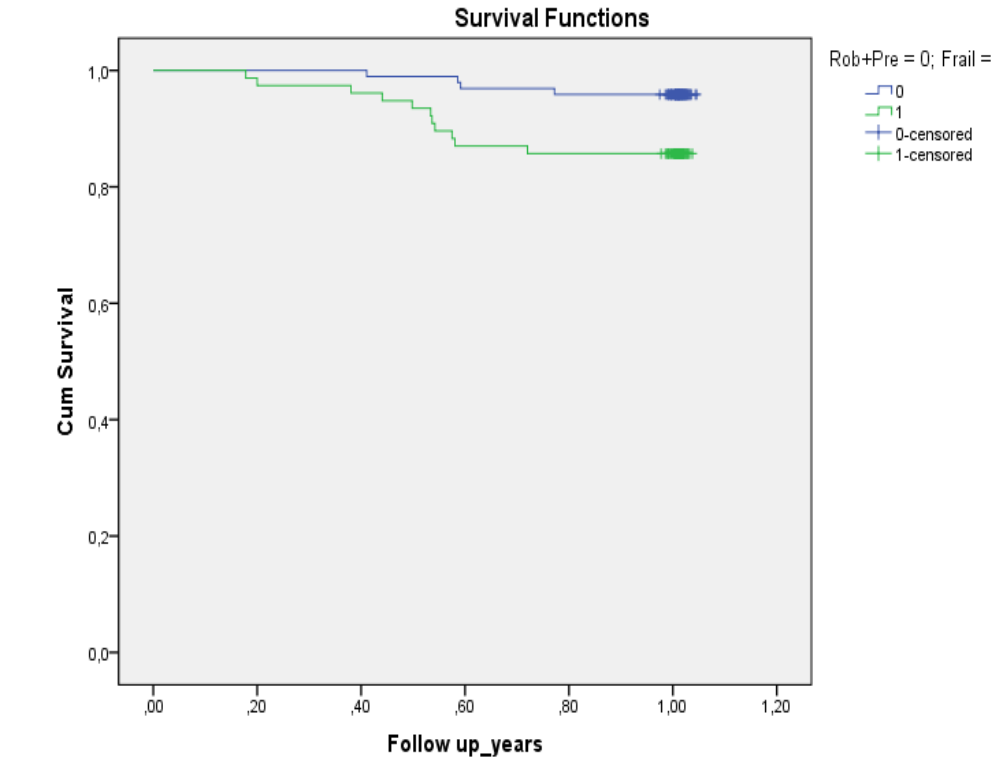
Figure 2. Survival at follow-up (12 months).